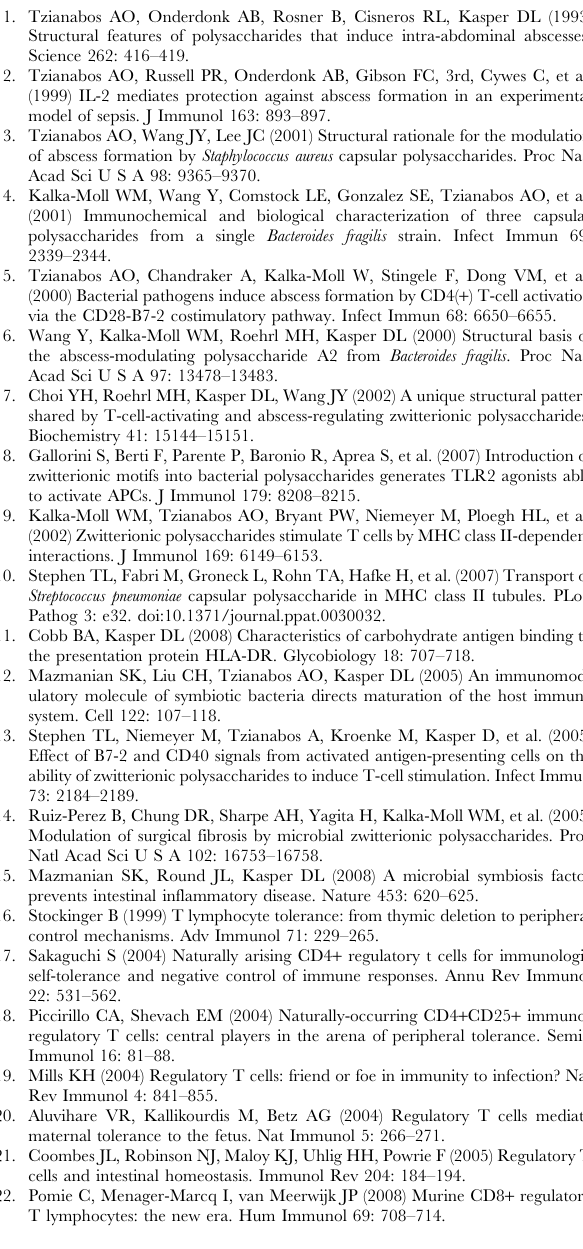
Figure S1 Purity of CD8 + CD28 2 and CD8 + CD28 2 T cells. CD28 2 and CD28 + CD8 + cells for adoptive transfer studies were sorted by flow cytometry as described in the Materials and Methods section and evaluated for their